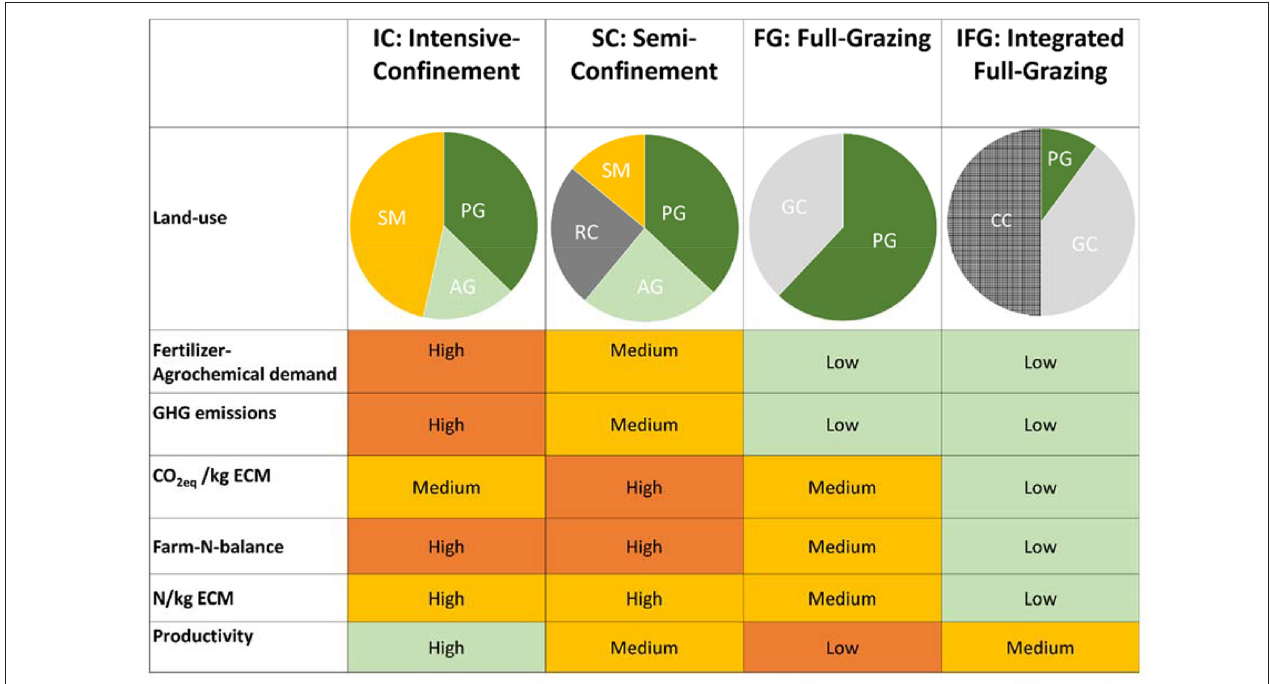
FIGURE 4 | Overview of different ecosystem services and productivity provided by the different land-use types and resource efforts in the investigated prevailing dairy